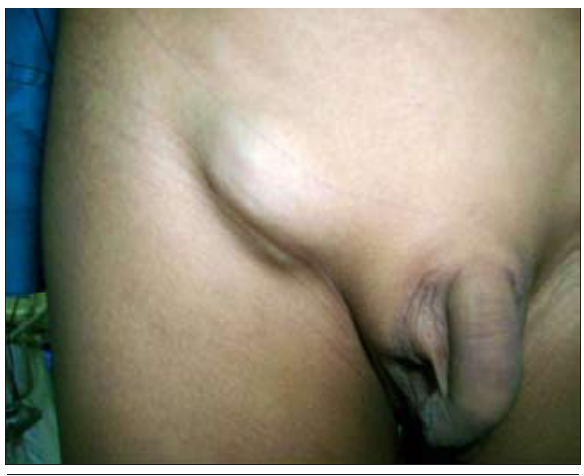
Figure 1. Clinical photograph showing a typical bulge of inguinal hernia.